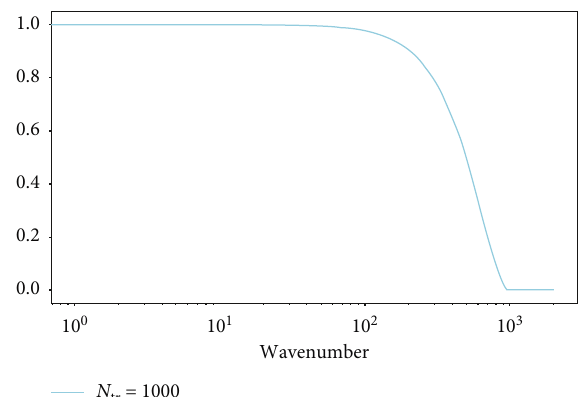
Figure 8: The coefficient of the spectral filtering method, truncated at N